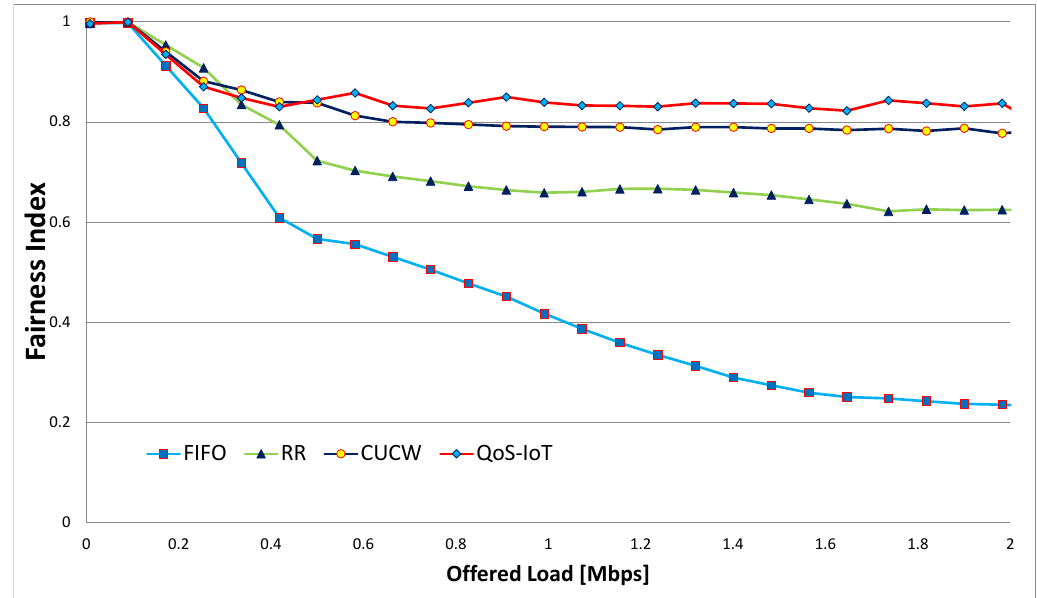
Figure 3. Fairness Indices with Sybil Nodes